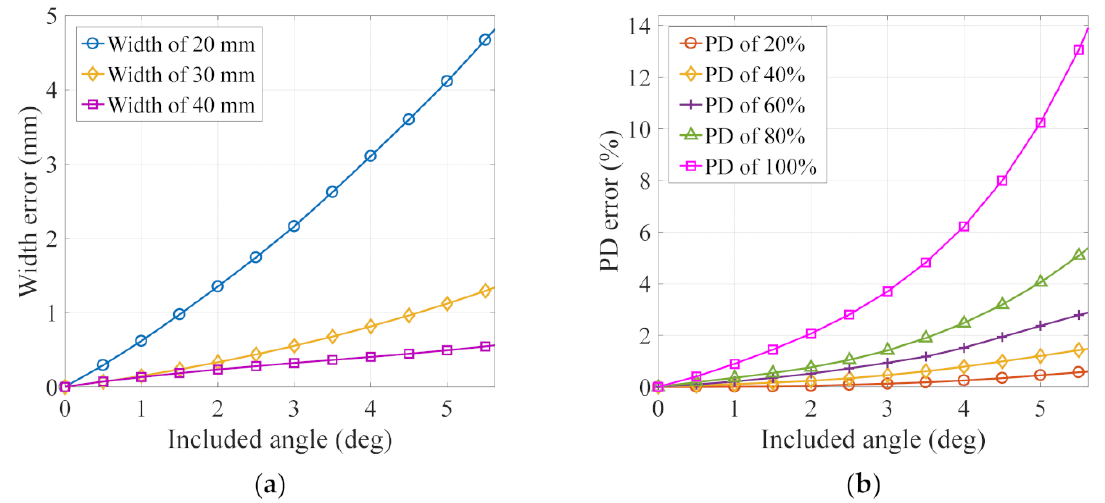
Figure 12. Errors of the circumferential width and PD with an included angle: ( a ) Width error for hole defect with a PD of 60%; ( b ) PD error for hole defect with a width of 20 mm.